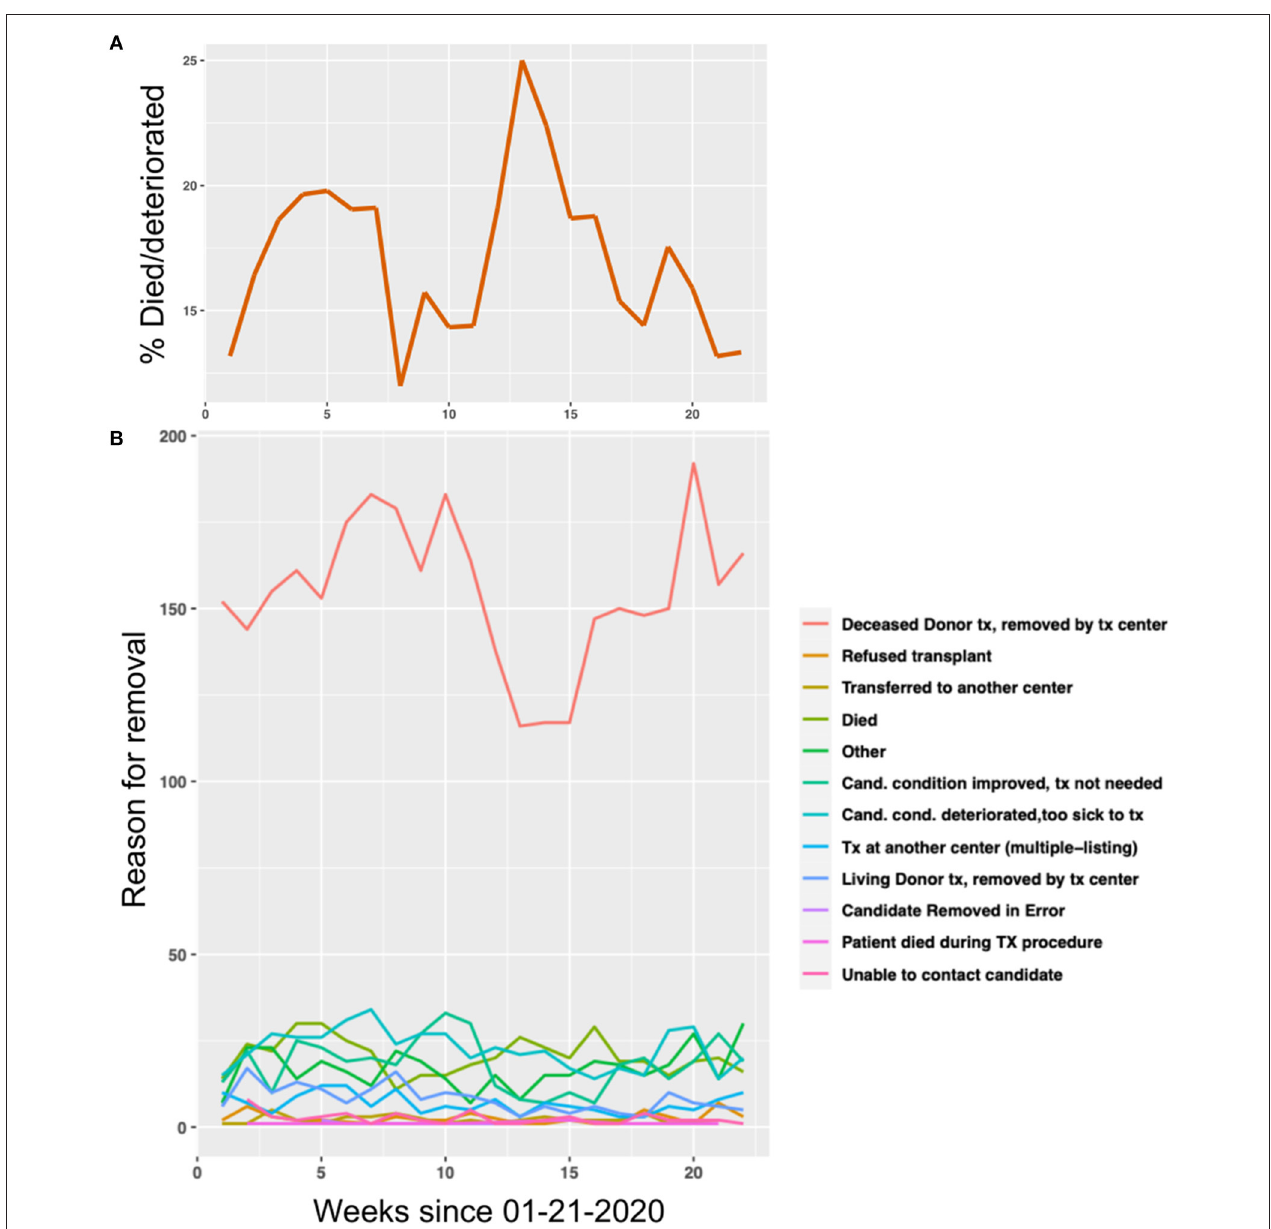
FIGURE 4 | The effect of the COVID-19 pandemic on liver transplant (LT) waitlist activity. (A) The percent of people in the United States who died or clinically deteriorated on the LT waitlist in 2020, by week. (B) The number of people removed from the LT waitlist in the United States, stratified by reason for removal, in 2020 by